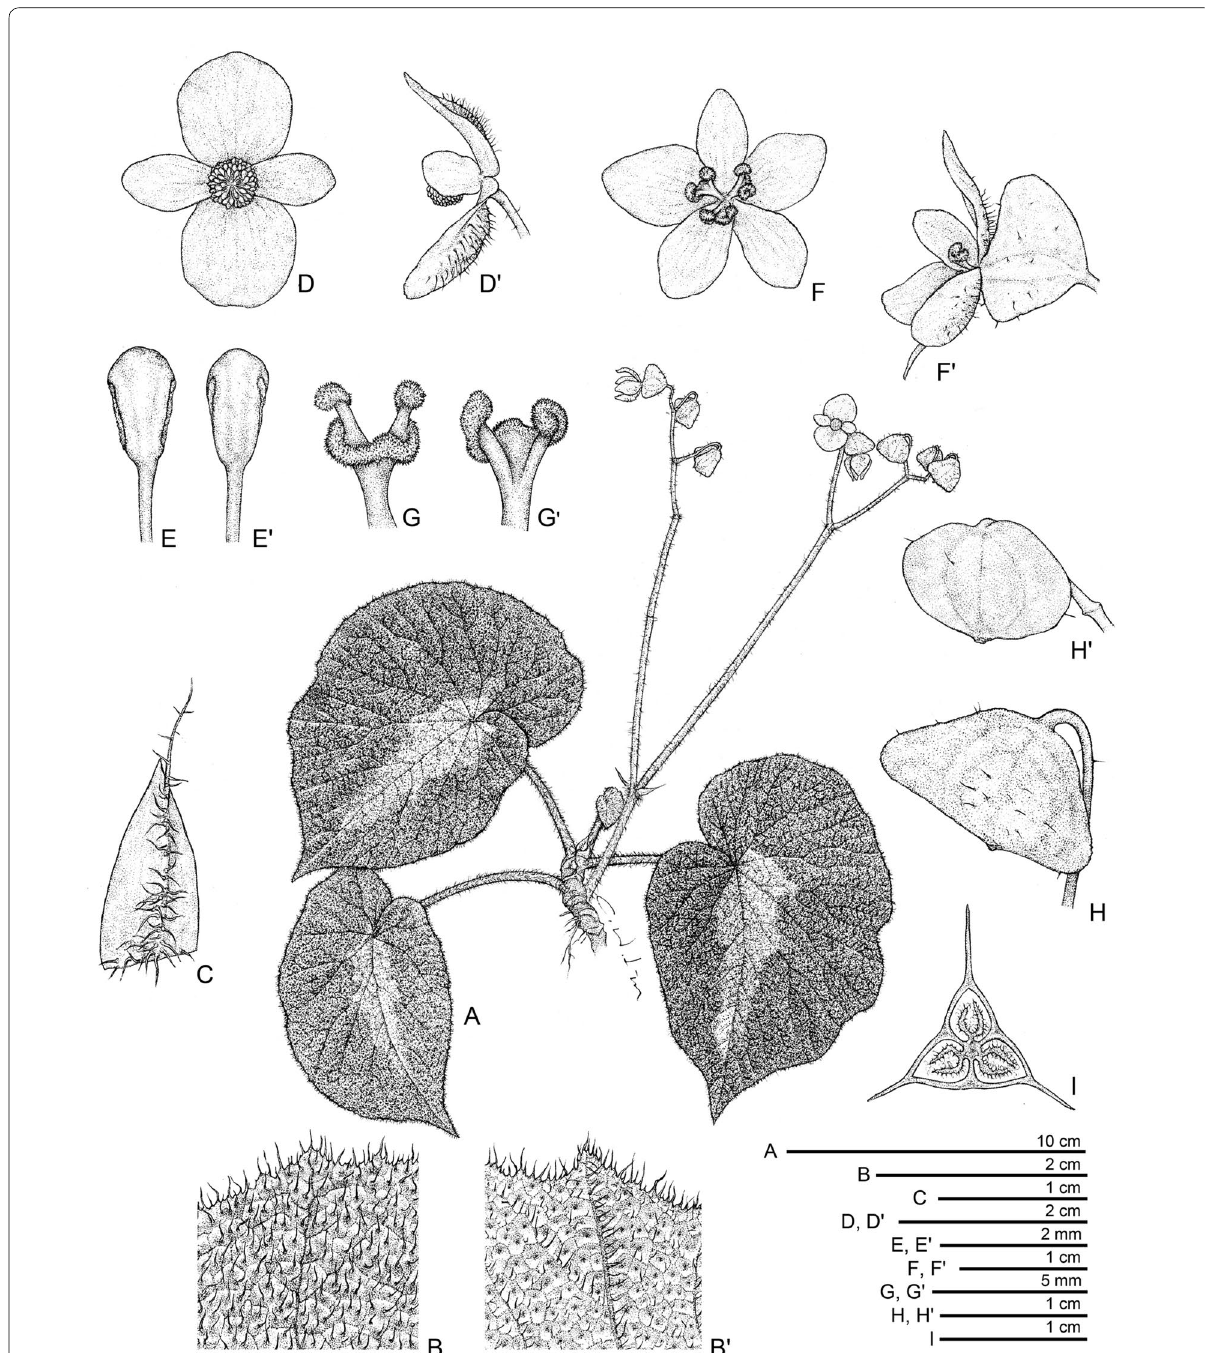
Fig. 3 Begonia aurora C.I Peng, Yan Liu, W.B.Xu. A Habit; B , B’ Portion of leaf, showing indumentum on adaxial and abaxial surfaces; C Stipule; D , D’ Staminate flower, face view and side view; E , E’ Stamen; F , F’ Pistillate flower, face view and side view; G , G’ Style and stigma; H , H’ Fruit; I Ovary cross section. A – C , H’ – I from Peng et al . 23696 , D – H from Peng et al .